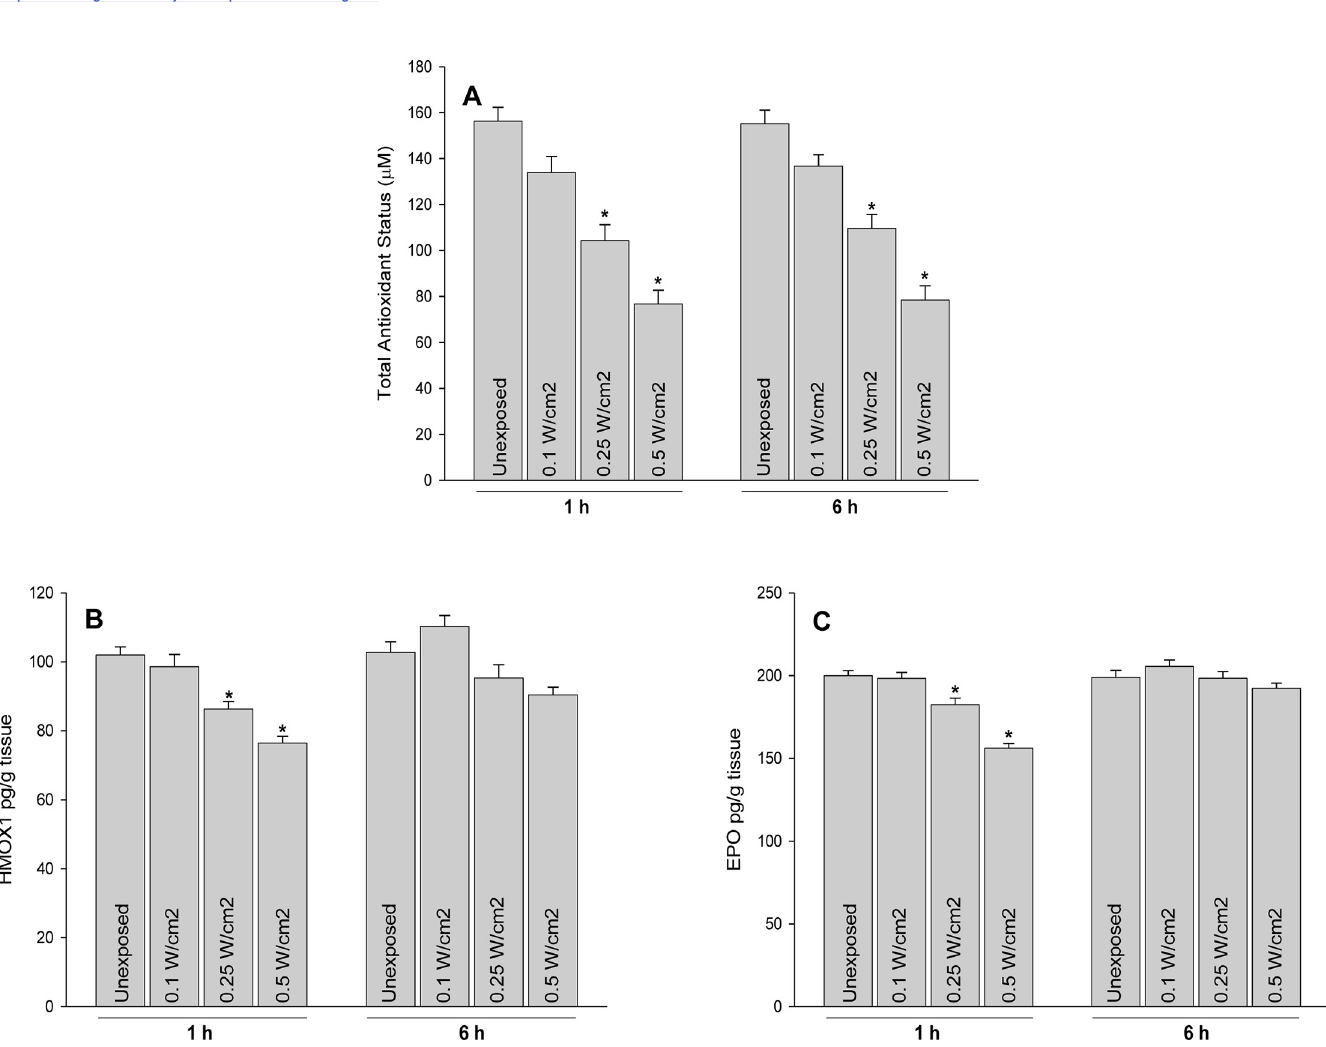
Fig 9. Validation of genes; ho1 gene (A) and ppard gene (B) using q-PCR in rat skin exposure 532 nm laser. The fold change for 0.1 W/cm 2 exposure was negligible to unexposed group and hence not depicted on graph.